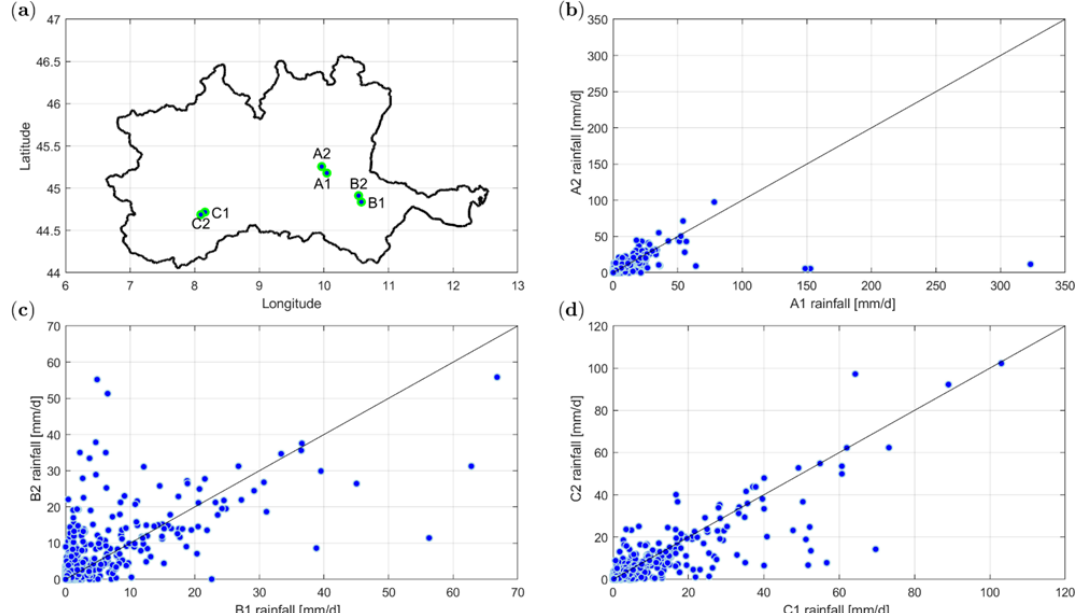
Figure 9. Panel (a) shows the boundary of the Po River basin, together with the position of three couple of stations (A1–A2, B1–B2 and C1–C2) with alleged “bad” MCM performance. The scatter plots of the daily rainfall measured by each couple of stations are then shown in (b) , (c) and (d)